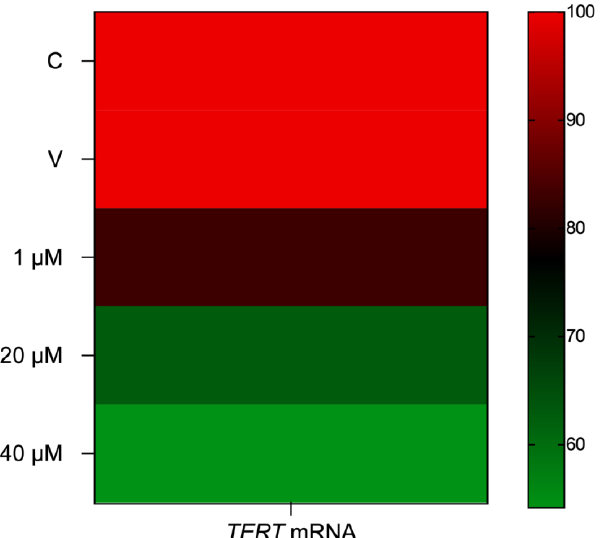
Figure 8. Heat map correlating eleutherine treatment with TERT mRNA expression in glioma cells. The color of each rectangle indicates the value of the Pearson correlation coefficient (ρ) between the eleutherine-treated groups and TERT mRNA expression.